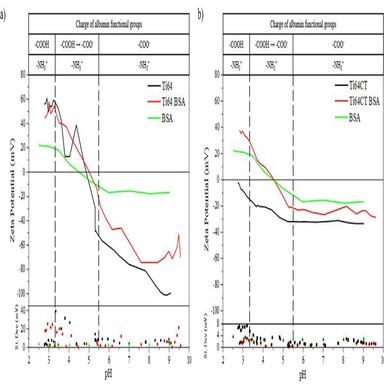
Zeta potential titration curves for untreated Ti64 (a), prior (black line) and after (red line) protein adsorption, and for Ti64CT (b), prior (black line) and after (red line) protein adsorption. The titration curve of native albumin in solution is also reported (green line). Standard deviations for each measured point are represented at the bottom of the graphs. The charge of the functional groups of the amino acids of BSA is reported on the top of the graphs for the different pH ranges.